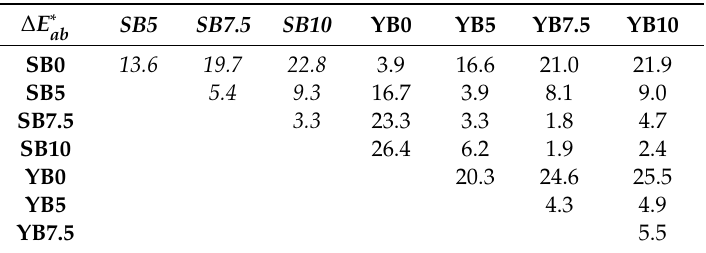
Table 6. Cie L*a*b* color di ff erences ( ∆ E ∗ already published in Sanmartin et al., 2020